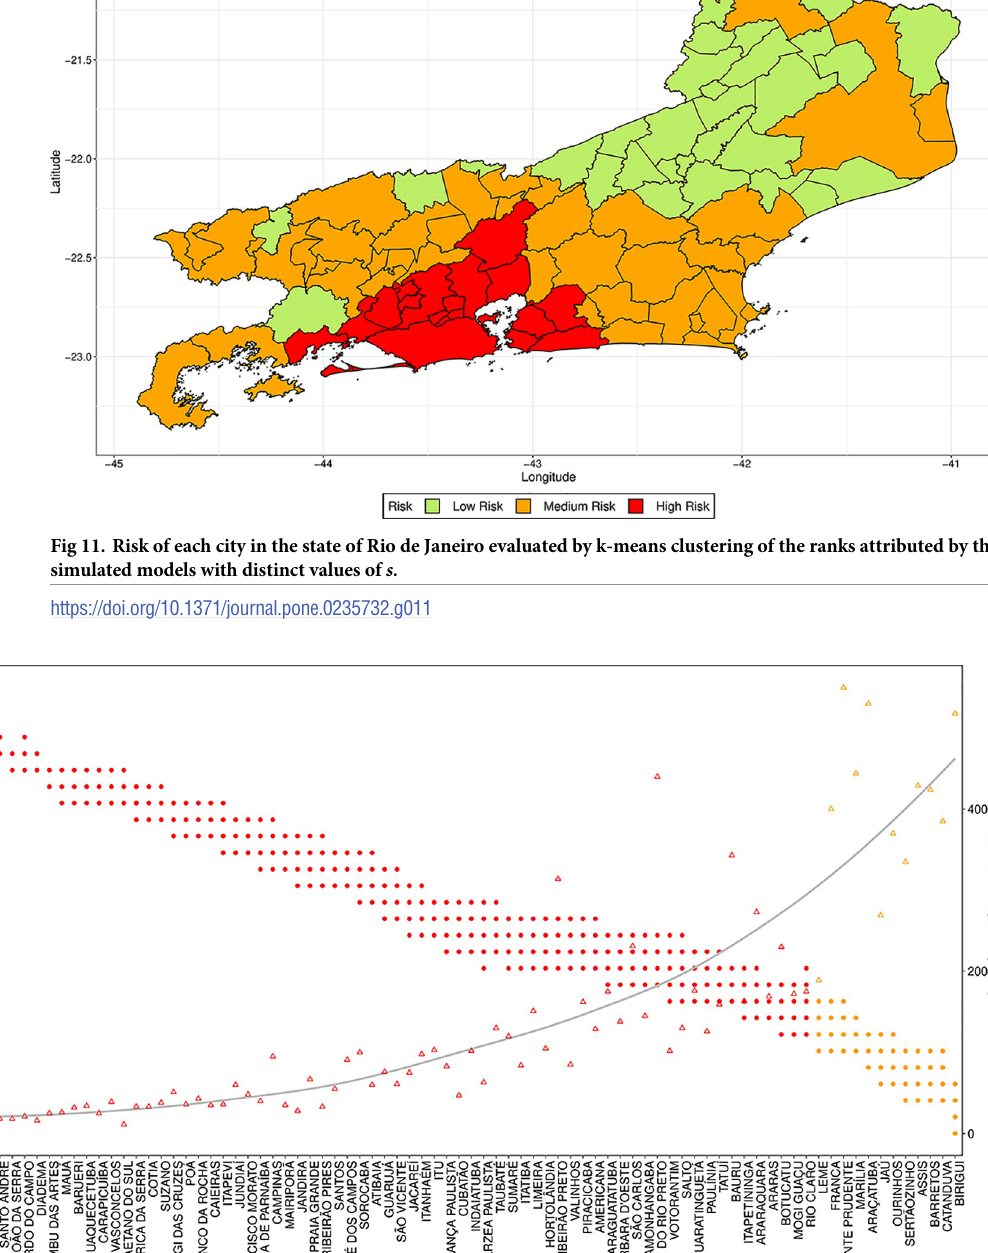
PLOS ONE | https://doi.org/10.1371/journal.pone.0235732 July 16,